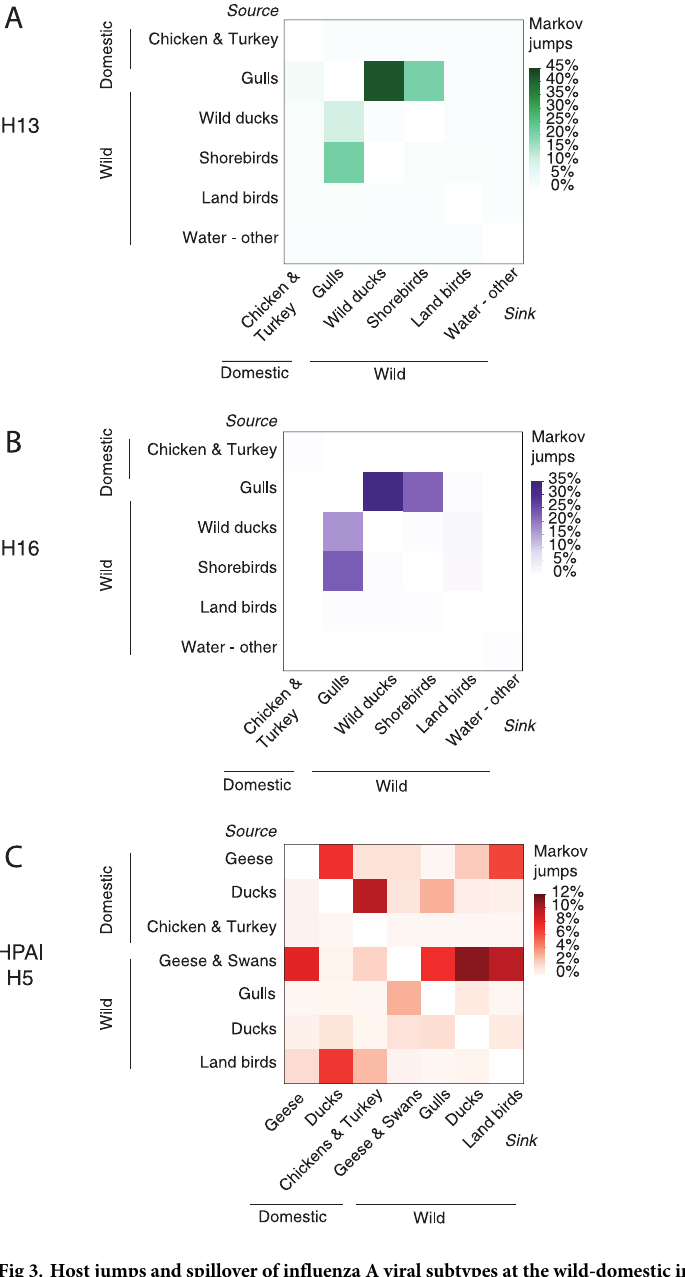
PLOS Pathogens| https://doi.org/10.1371/journal.ppat.1010062 May 19,